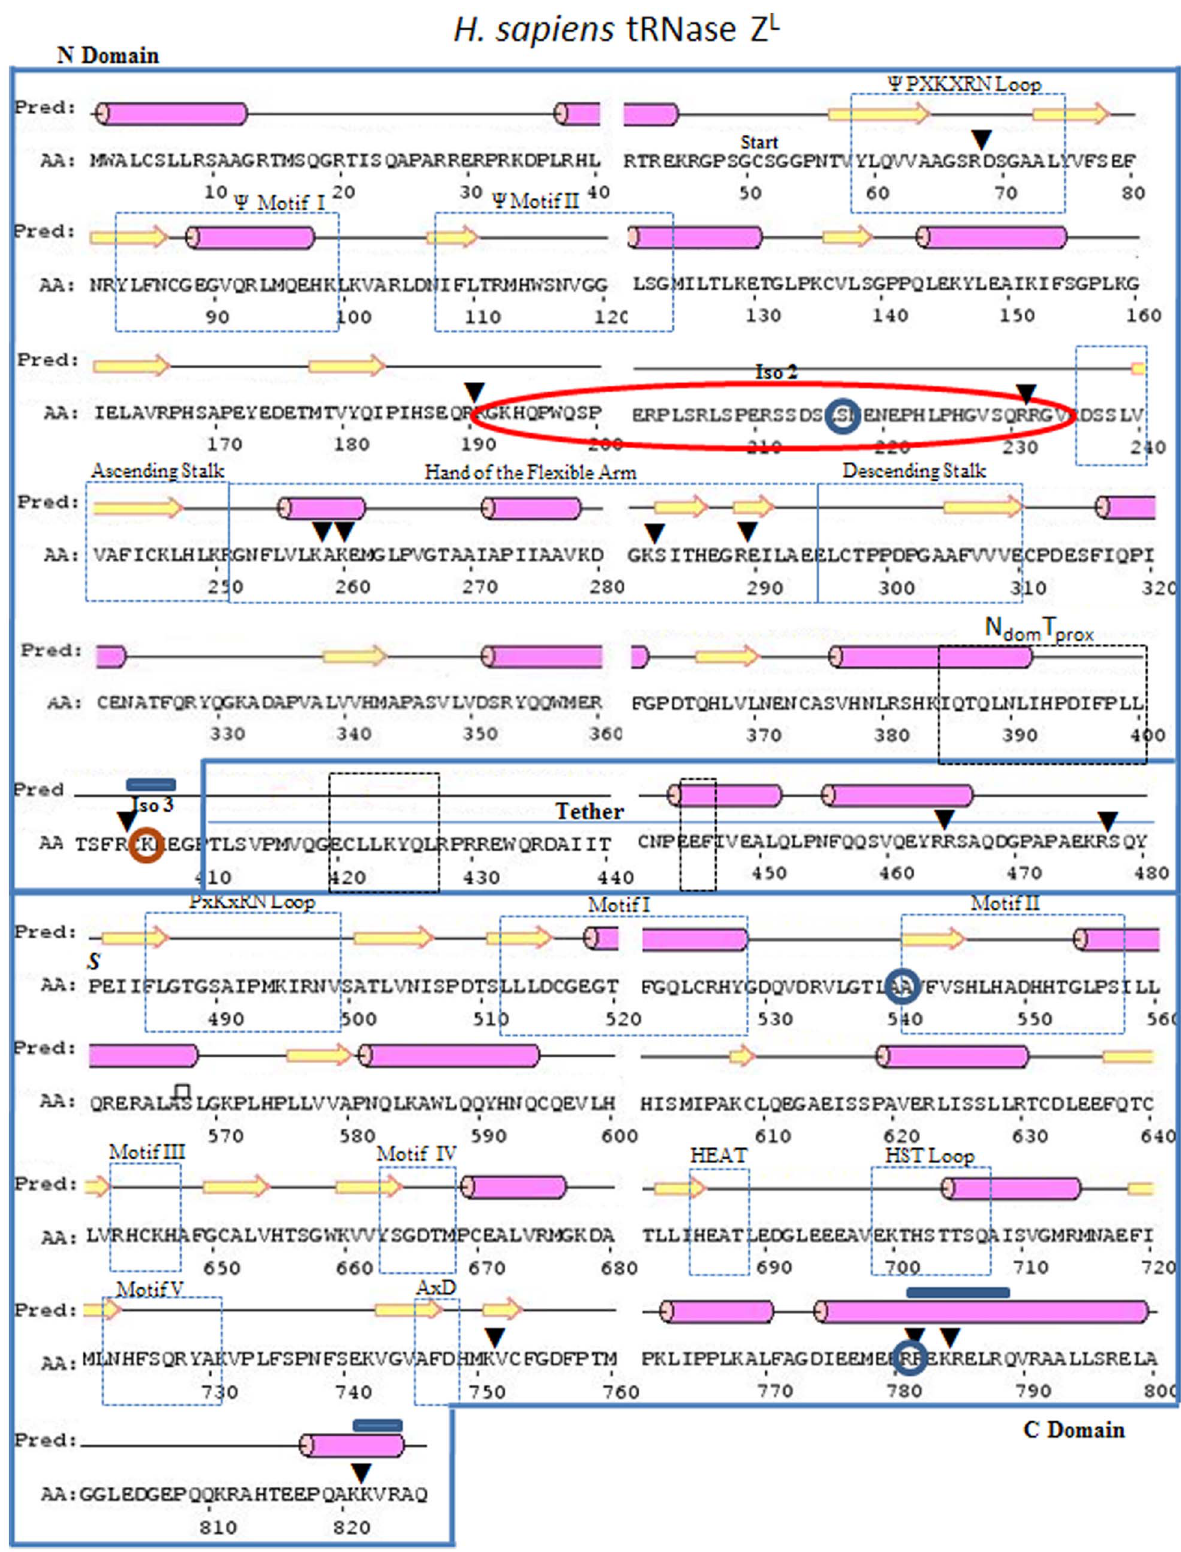
Figure 7. Sequence and predicted secondary structure of H.sapiens tRNase Z L (Psipred). Enclosed regions N dom , Tether and C dom and annotation of functional motifs are as in Figure 4. Polymorphisms and isoforms (identified by enclosure in blue circles and orange ellipses, respectively) are described in detail in Supplement.